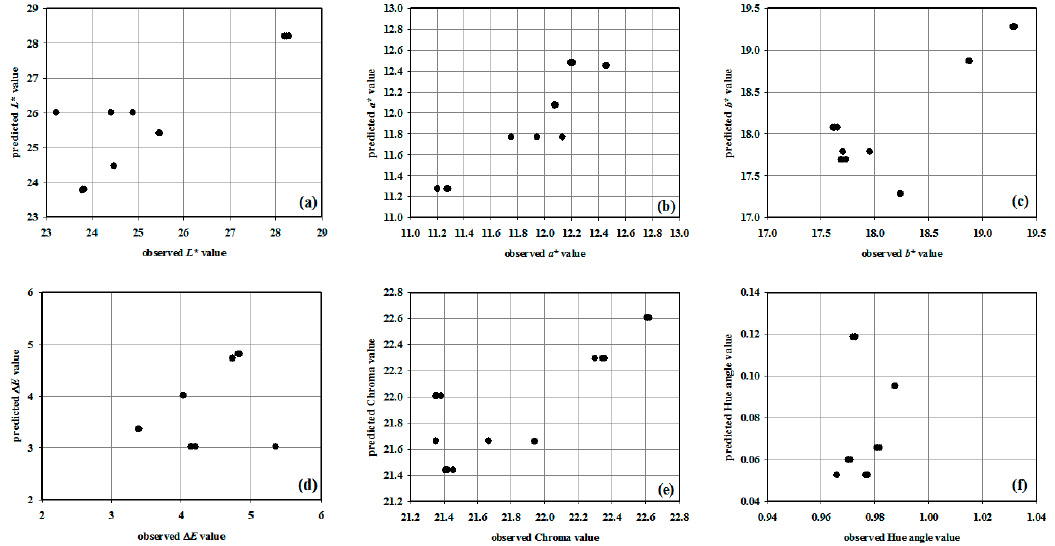
Figure 1. Non-linear regression models for description of color component change during storage of L1KMK estimated using Eureqa Formulize: ( a ) L *, ( b ) a *, ( c ) b *, ( d ) ∆ E , ( e ) Chroma, ( f ) Hue angle ( R 2 = 0.737, 0.842, 0.258, 0.611, 0.519, 0.488). Table 2. Non-linear regression models coefficients for description of color component change during storage for L1KMK ( α = 95%) estimated using Eureqa Formulize software.